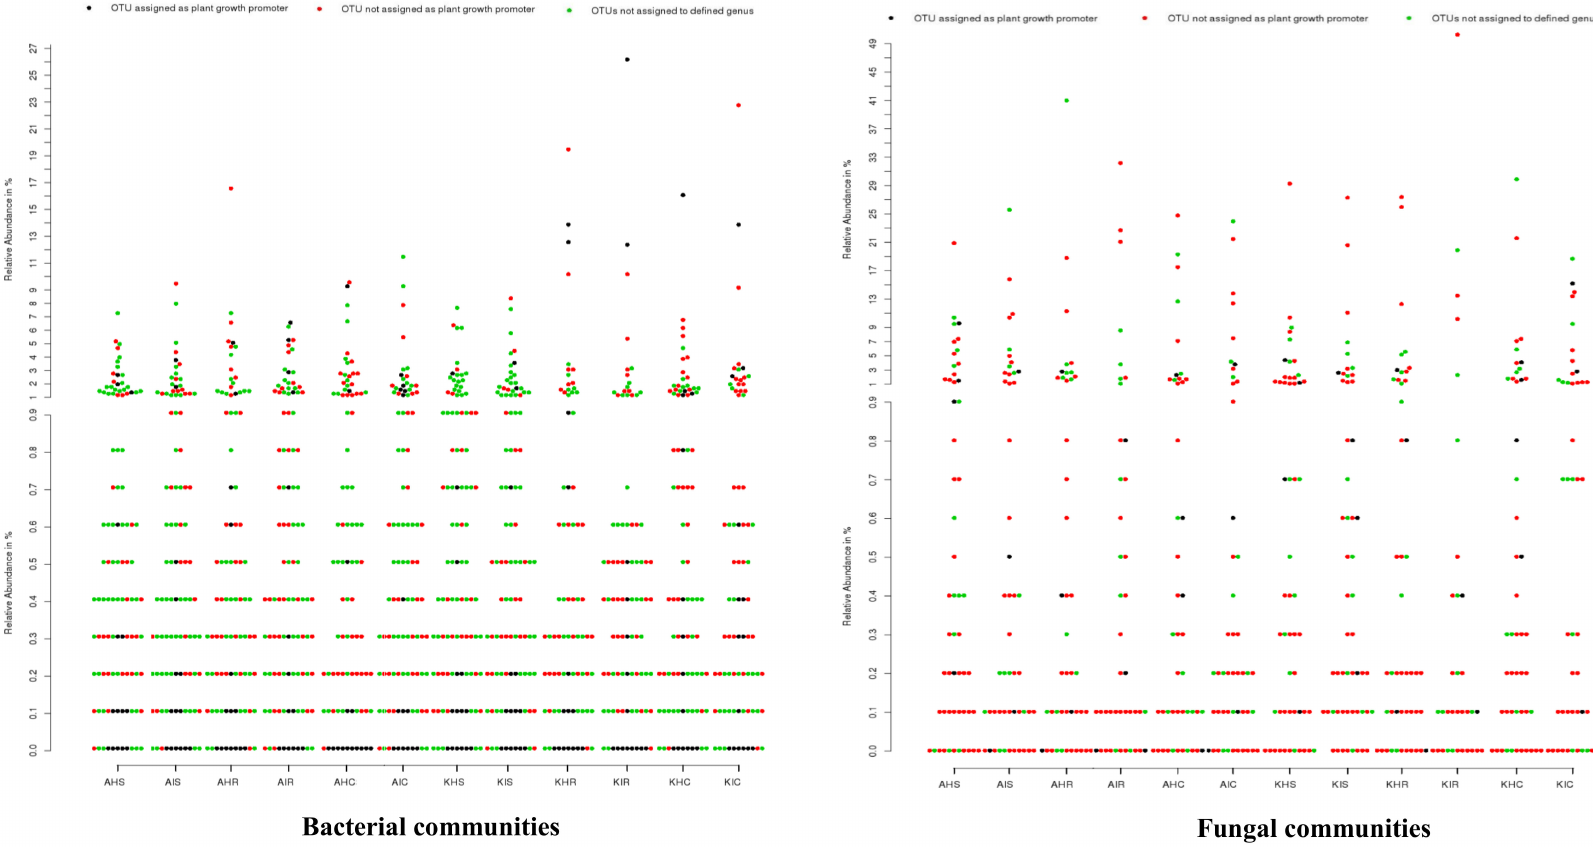
Figure 8. Untapped diversity in bacterial and fungal communities. The relative abundance of core OTUs is demonstrated by dots in a sample type. Dot representing OTUs where, black dots represent OTUs assigned as plant growth promoter, red dots represent OTUs unassigned as plant growth promoter, and green dots represent OTUs not assigned to a defined genus. Majority of core OTUs exhibit no functional indications in association with hosts. A: Arusha; C: Corm; H: Asymptomatic; I: Symptomatic; K: Kilimanjaro; R: Roots; S: